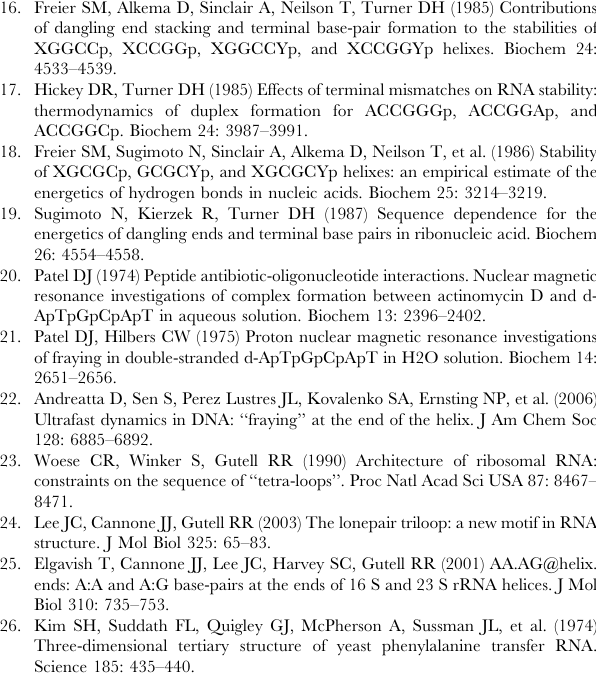
Positions of capping